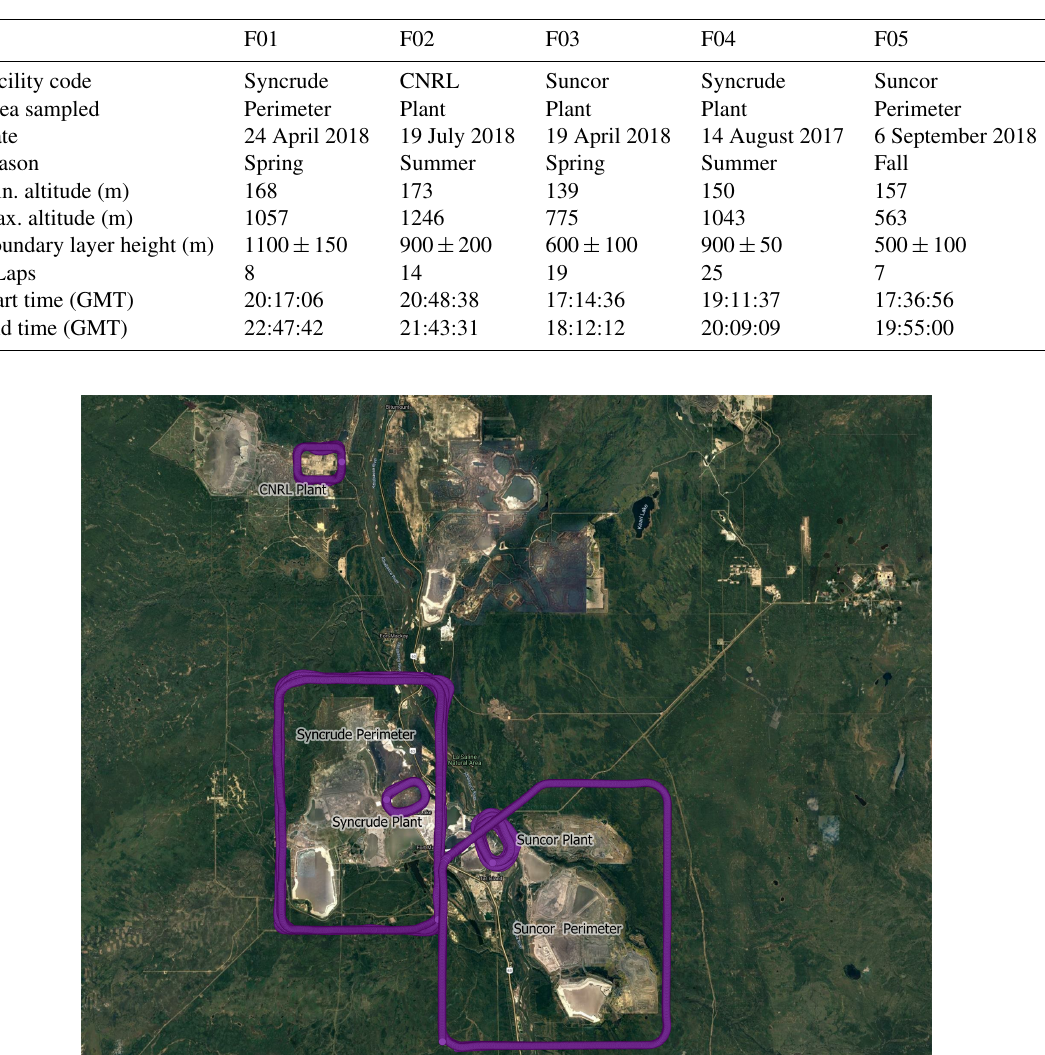
Table 2. Information on the five box-flight samples used in the comparative analysis.